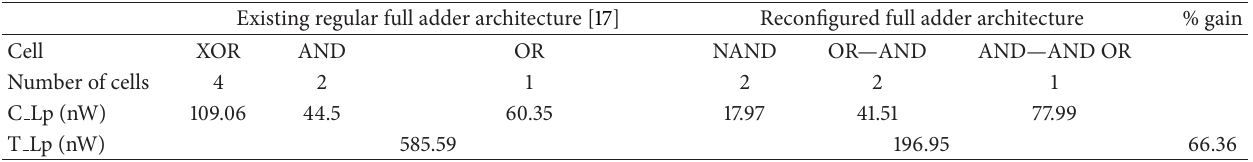
Table 2: Leakage power of the existing and proposed full adder architecture.